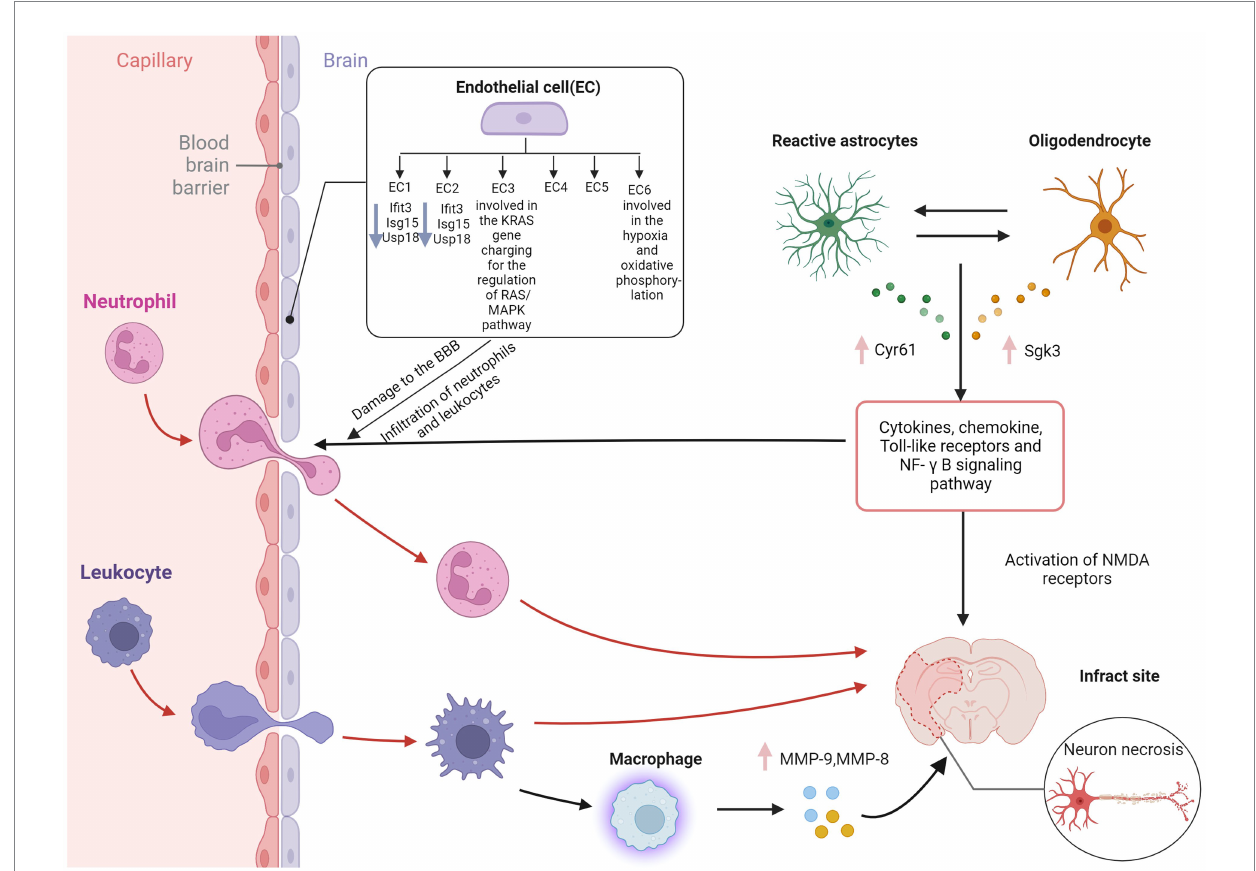
FIGURE 2 Blood–brain barrier disruption in ischemic stroke. EC, endothelial cell; IFIT3, interferon induced protein with tetratricopeptide repeats 3; Isg15, interferon-stimulated gene 15; USP18, ubiquitin-specific protease 18; Cyr61, cysteine-rich protein 61; Sgk3, serum and glucocorticoid induced kinase; MMP-9, matrix metallopeptidase 9; MMP-8, matrix metallopeptidase 8; NF- κ B, nuclear factor kappa-B; NMDA receptor, N-methyl-D-aspartic acid receptor; BBB, blood–brain barrier. Figure was created with